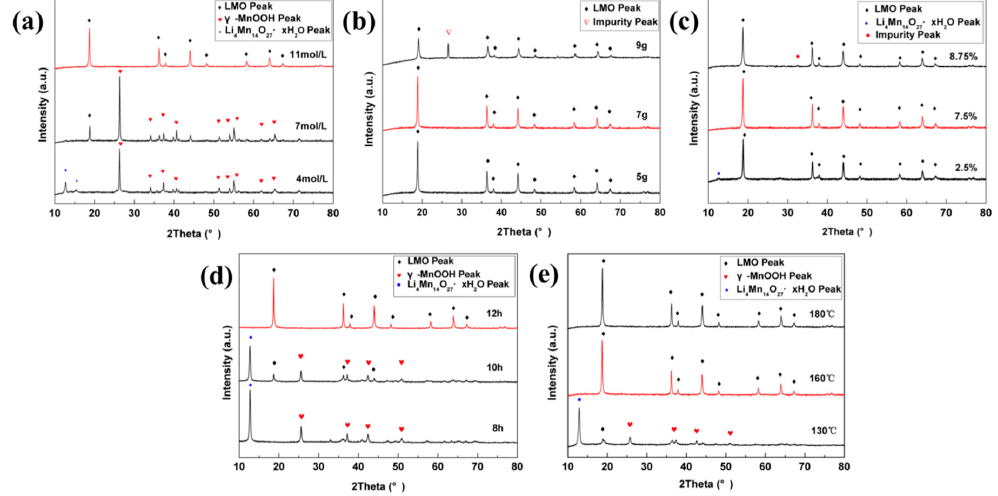
Figure 2. X-Ray diffraction (XRD) patterns of resultant under different preparation conditions: ( a ) the concentration of Li + ; ( b ) the amount of KMnO 4 ; ( c ) the volume ratio of ethanol; ( d ) reaction time; ( e ) reaction temperature.